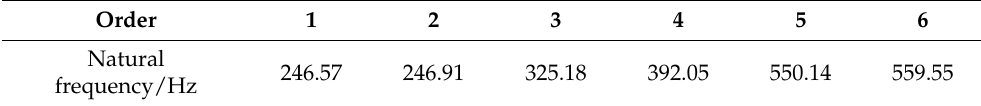
Table 3. The eigenfrequency of the microgripper.